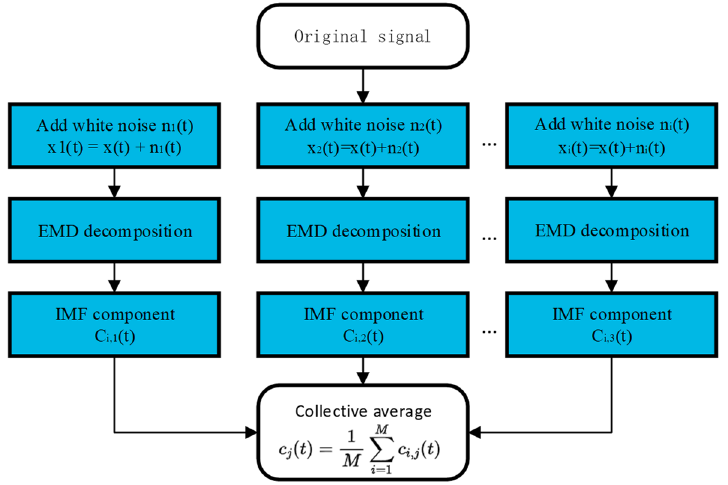
Figure 13. The rendering of EEMD.